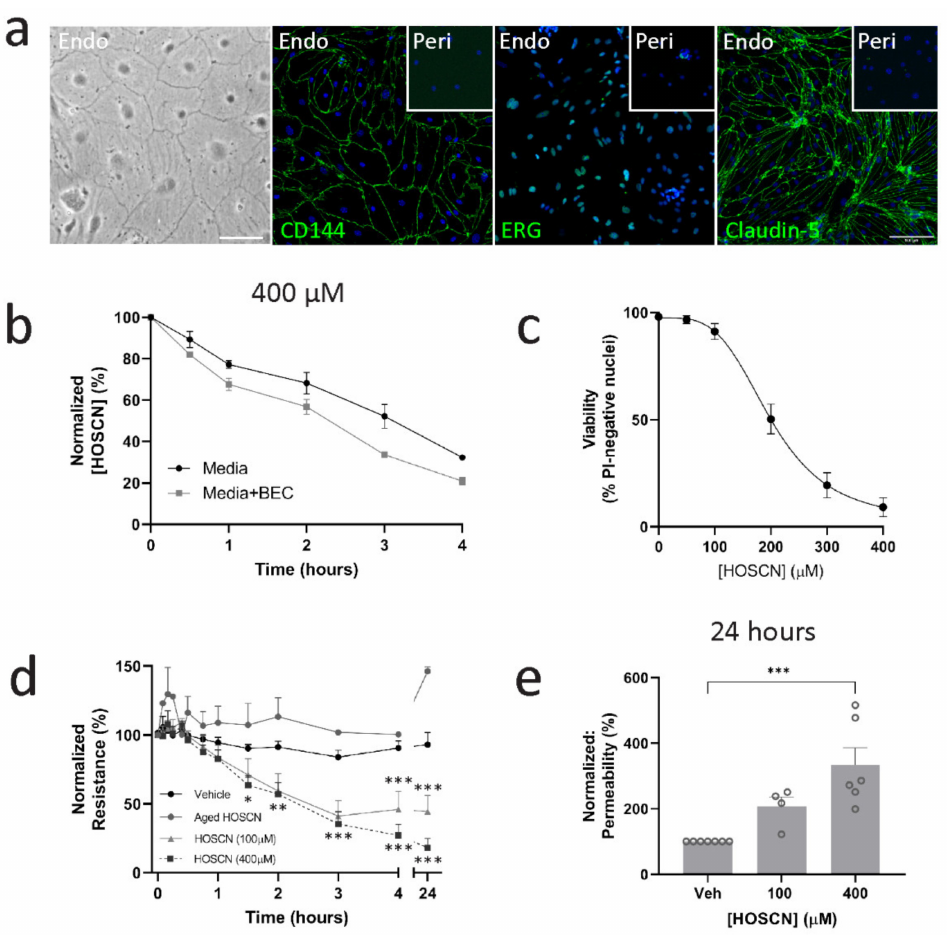
Figure 1. Hypothiocyanous acid (HOSCN) affects brain endothelial cell (BEC) barrier function independent of cell death. ( a ) Representative images of confluent BEC in phase contrast, and stained with endothelial markers CD144, ETS-related gene (ERG), and claudin-5, which are absent in pericytes. Scale = 100 µ m. ( b ) HOSCN was added directly to media and concentration was measured over time with or without the presence of BECs. n = 3. ( c ) BECs were treated with different concentrations of HOSCN for 24 h and viability measured by imaging propidium iodide incorporation. n = 3. ( d ) Transendothelial electrical resistance (TEER) was measured over time, and BECs were treated when at least 100 Ω · cm 2 was reached with HOSCN for 24 h. Data are